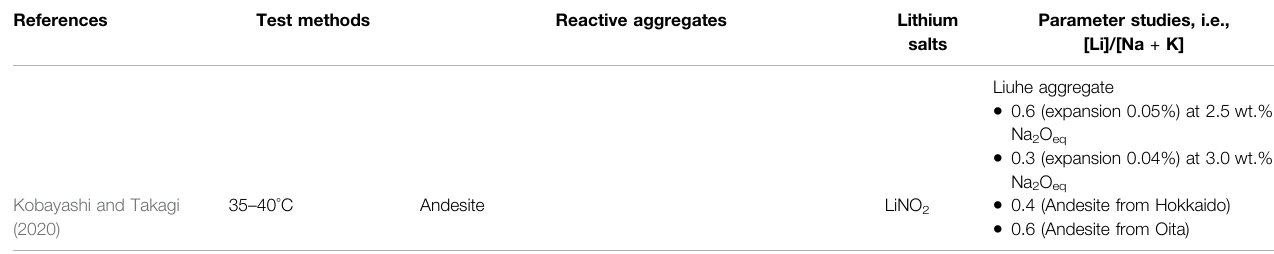
TABLE 1 | ( Continued ) Summary of selected research fi ndings related to the lithium dosage ([Li]/[Na + K] molar ratio) needed to suppress ASR expansion and their test conditions. The table is adapted based on the version published in (Folliard et al.,